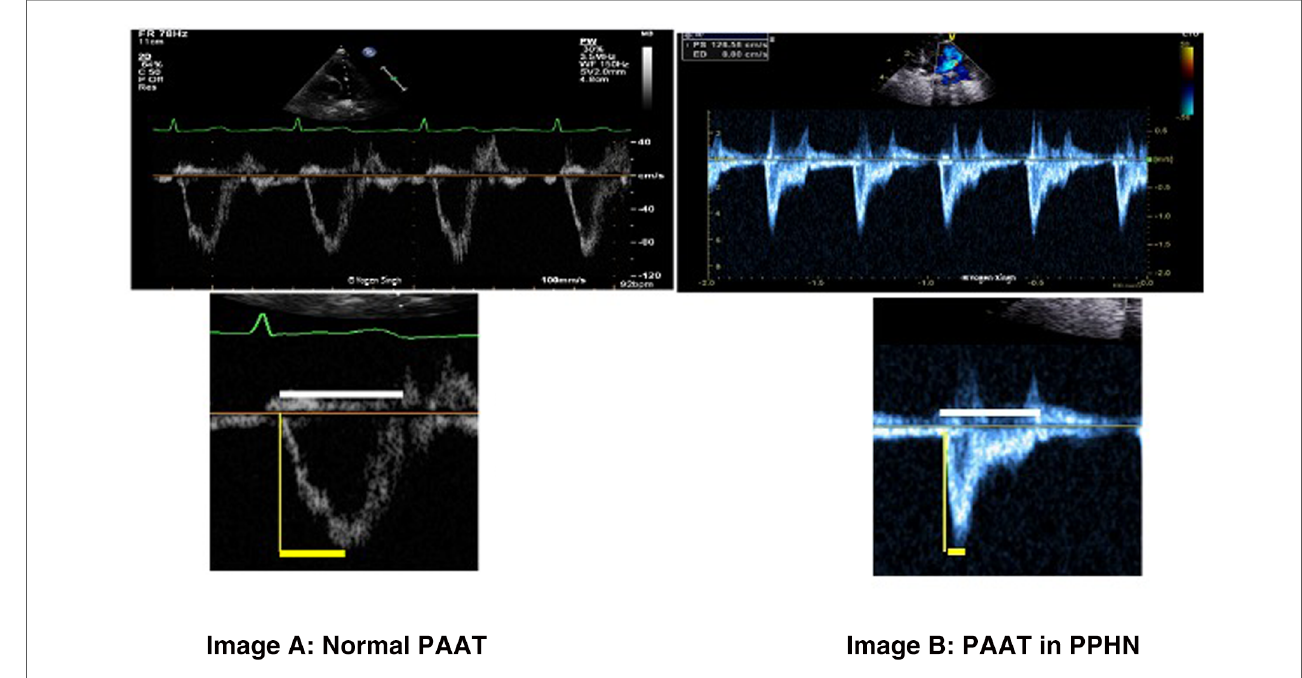
FIGURE 7 Pulmonary artery acceleration time (PAAT) measurement. Image “ A ” shows normal ratio of PAAT and right ventricular ejection time (RVET) in a normal child. Image “ B ” shows signi fi cantly decreased PAAT and increased PAAT/RVET ratio suggestive of pulmonary hypertension. “ Dicrotic notch ” may be seen on pulse- wave Doppler spectral in the pulmonary artery.